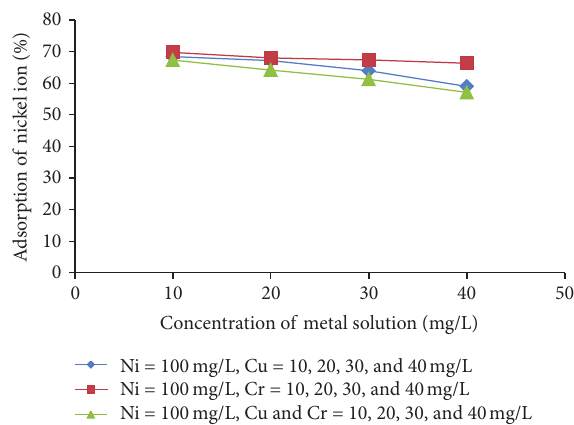
F 8: Effect of Initial concentration of Ni